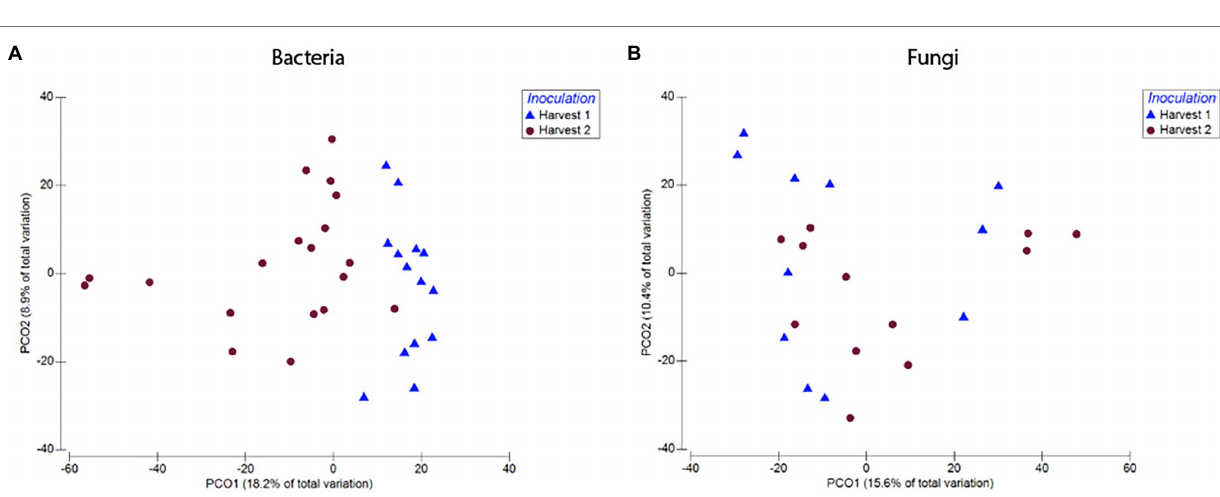
FIGURE 4 | Compositional differences in bacterial (A) and fungal (B) communities of roots harvested immediately prior to, and 2 weeks after, exposure to soil. Bacterial communities differed significantly between roots harvested before and after inoculation (pseudo- F = 2.89, p = 0.0001). There was also a difference between fungal communities in roots harvested before and after inoculation (pseudo- F = 1.57, p = 0.03). Dots represent pairwise differences (measured as Bray–Curtis